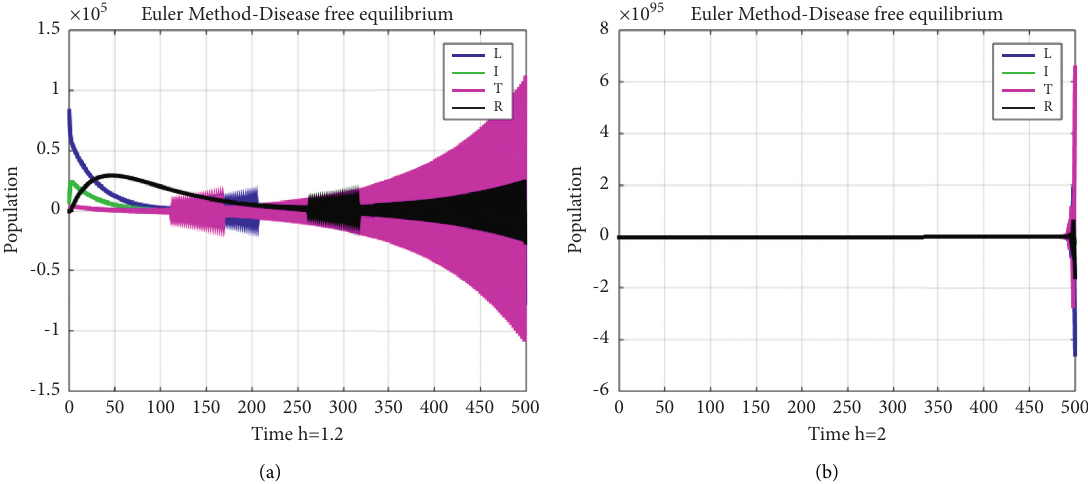
Figure 1: Simulations of forward Euler at disease-free equilibrium for step size h � 1 . 2 and h � 2. (a) Simulations of forward Euler. (b) Simulations of forward Euler.